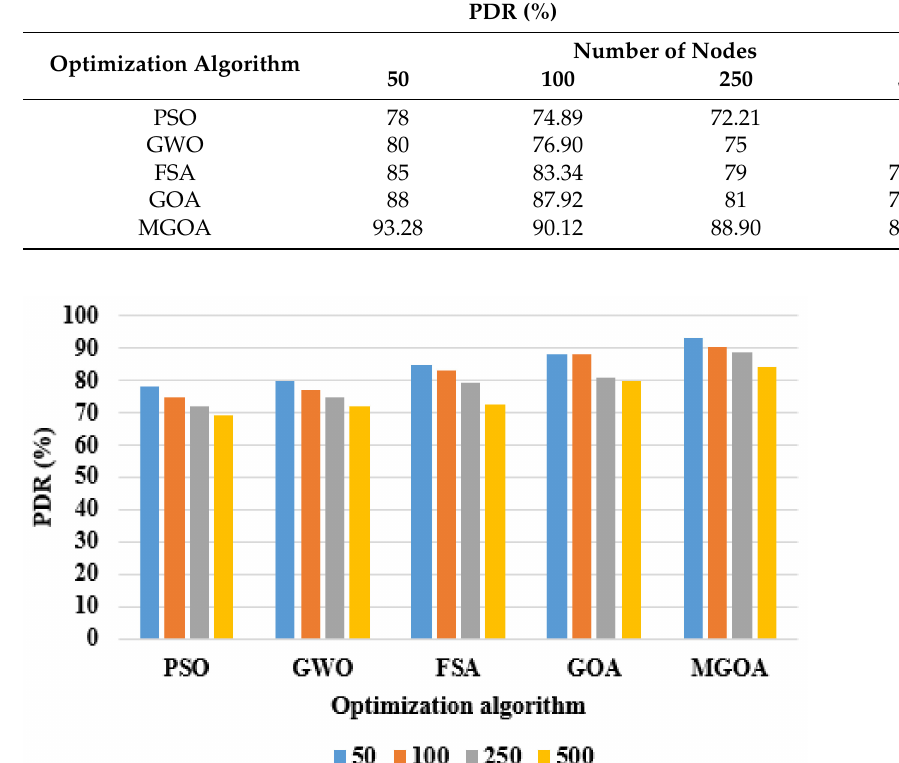
Figure 4. Graphical analysis of MGOA-WAVLCN in terms of